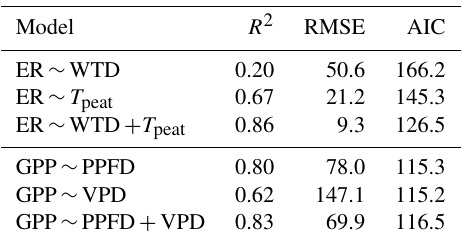
Table 2. Regression statistics for comparison of simple linear single- and dual-driver models explaining summertime and autumn monthly ER and GPP over the 4 measurement years. Root mean square error (RMSE) and Akaike’s information criterion (AIC) are given as measures of model error and relative quality, where a lower AIC value is